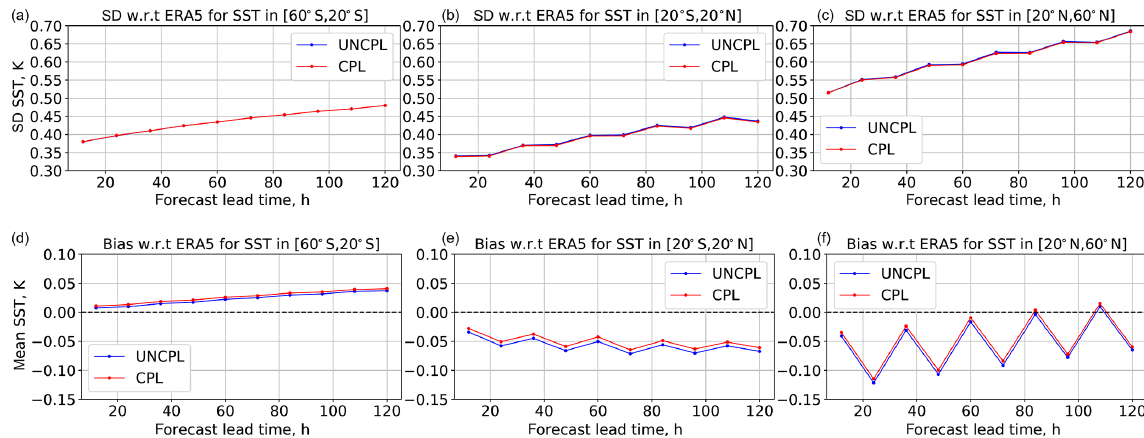
Figure 9. Standard deviation (a, b, c) and bias (d, e, f) (K) with respect to the ERA5 reanalysis daily mean SST fields as a function of forecast lead time. The statistics are computed for UNCPL (blue curves) and CPL (red curves) in three latitude bands: southern extratropics between 20 and 60 ◦ S (a, d) , tropics between 20 ◦ S and 20 ◦ N (b, e) , and northern extratropics between 20 and 60 ◦ N (c, f)